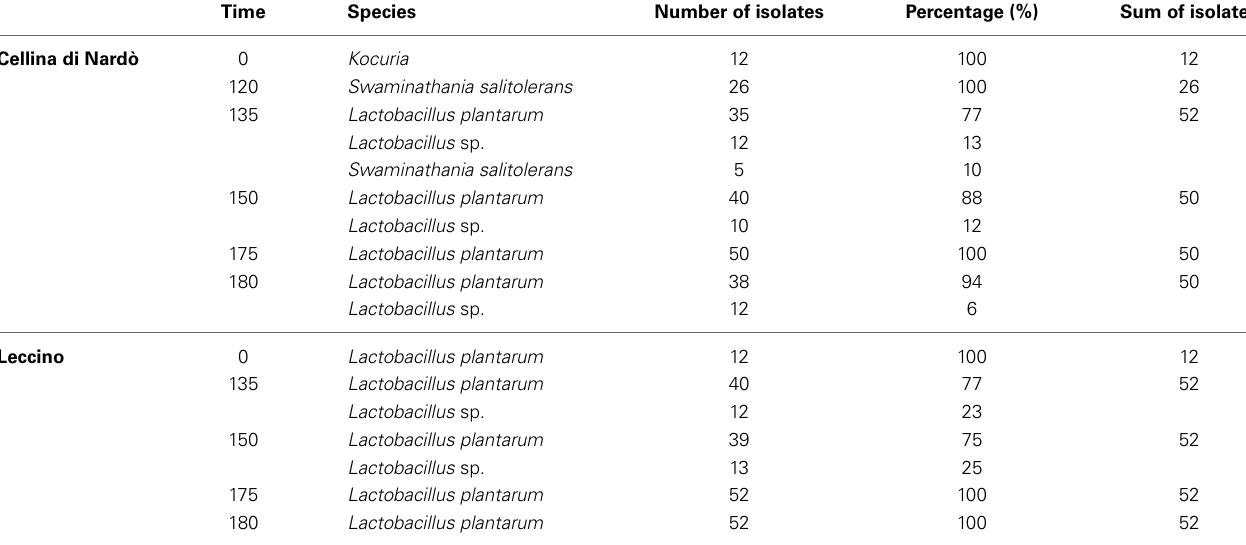
Table 2 | Bacteria isolates identified during spontaneous fermentation of Cellina di Nardò and Leccino